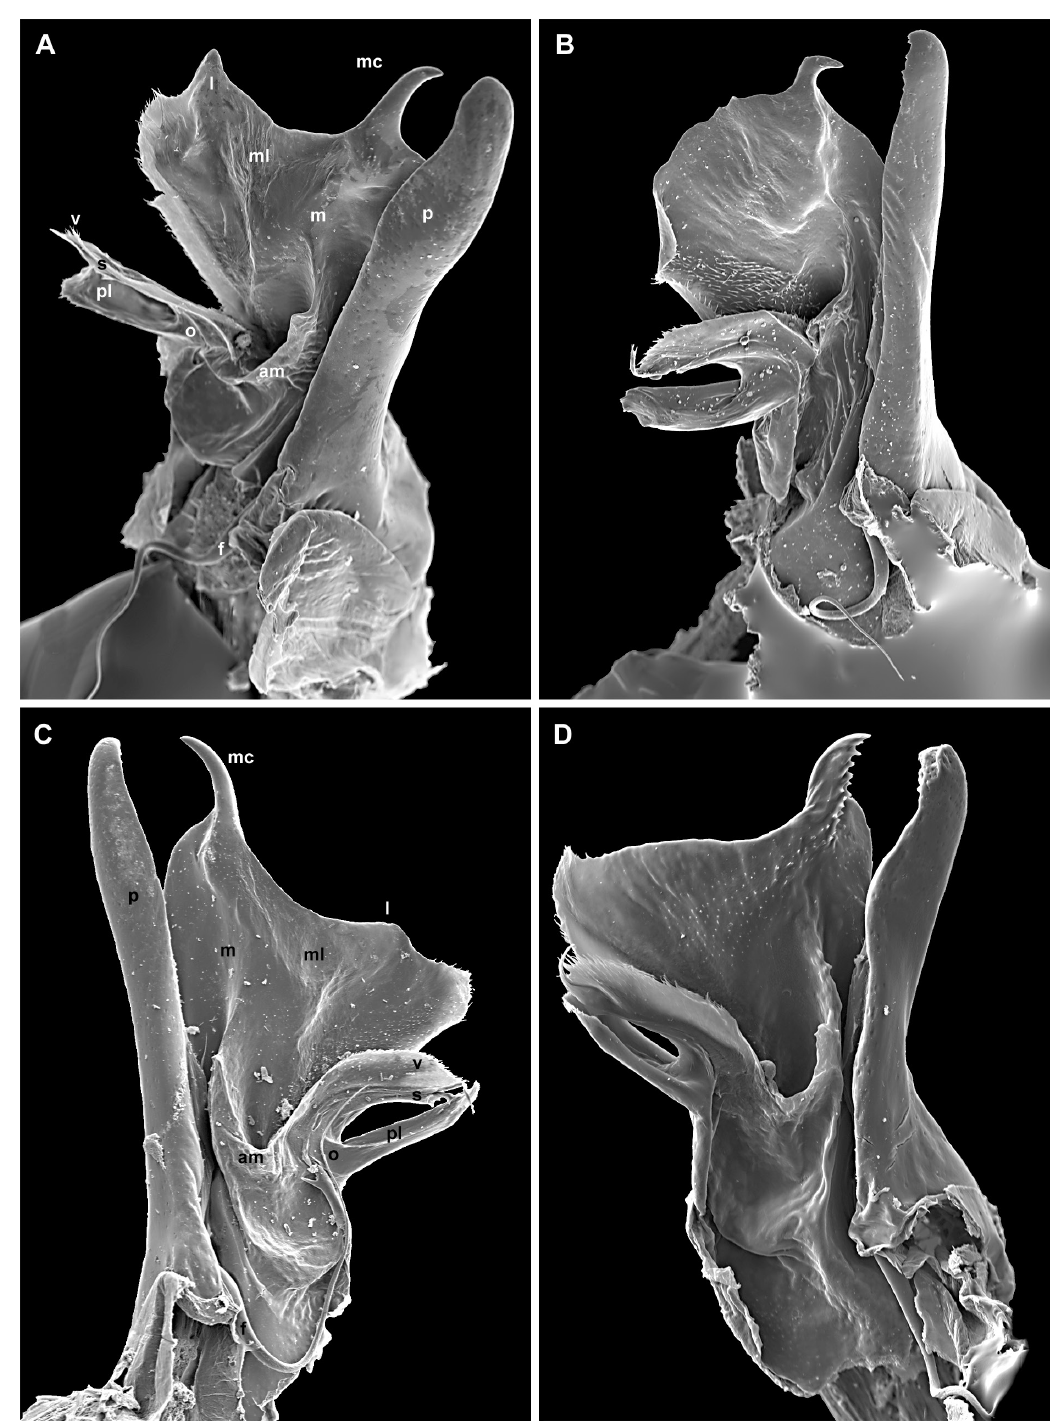
Fig. 2. Gonopods, mesal view. A . Leucogeorgia lobata sp. nov., right gonopods, paratype ♂ from Kalitshona Cave (ZMUM). B . L. longipes Verhoeff, 1930, right gonopods, ♂ from Dolabistavi Cave (SMNG). C . L. prometheus sp. nov., left gonopods, non-type ♂ from Sataplia II Cave (ZMUM). D . L. satunini (Lohmander, 1936) comb. nov., right gonopods, ♂ from Kelasurskaya Cave (ZMUM). Abbreviations: am = accessory membrane; f = flagellum; l = lobe; m = mesomere; mc = mesomeral claw; ml = mesomeral lamella; o = opisthomere; p = promere; pl = protective lamella; s = solenomere; v =